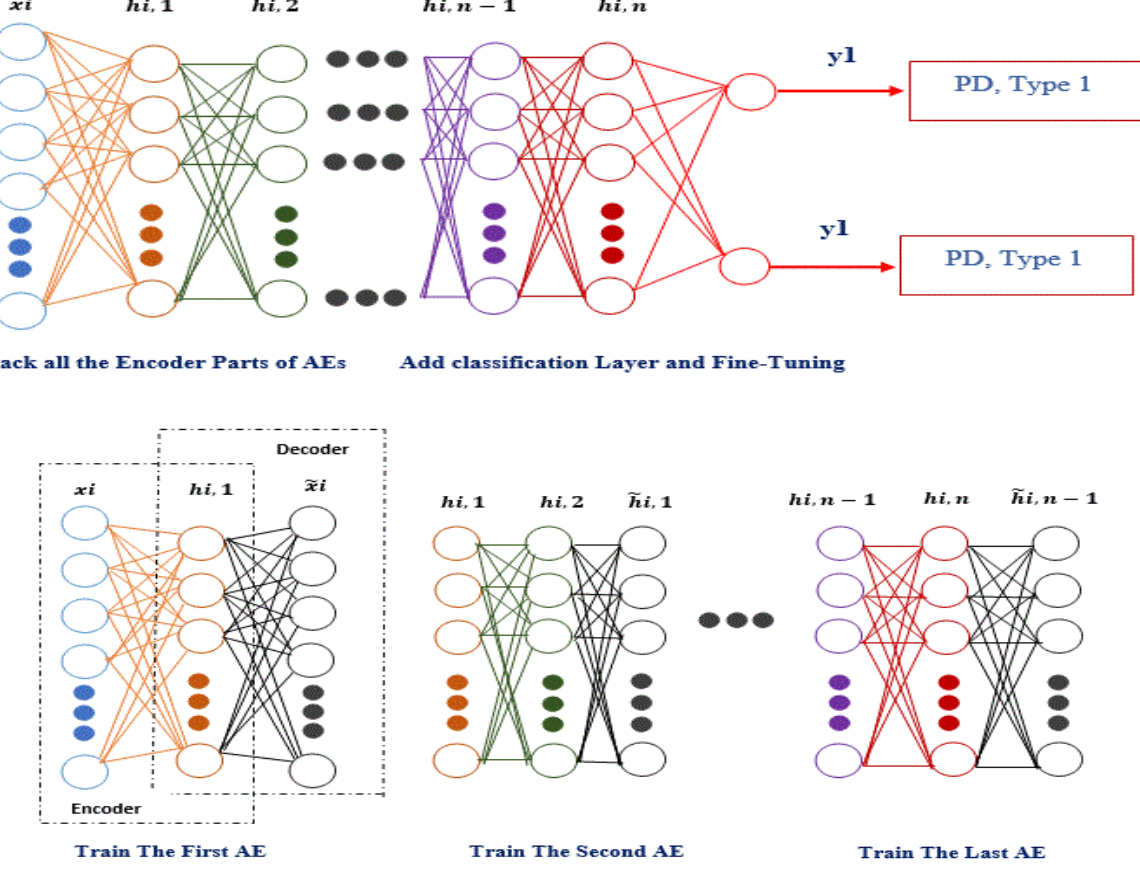
Figure 19. Stacking AE diagram for PD